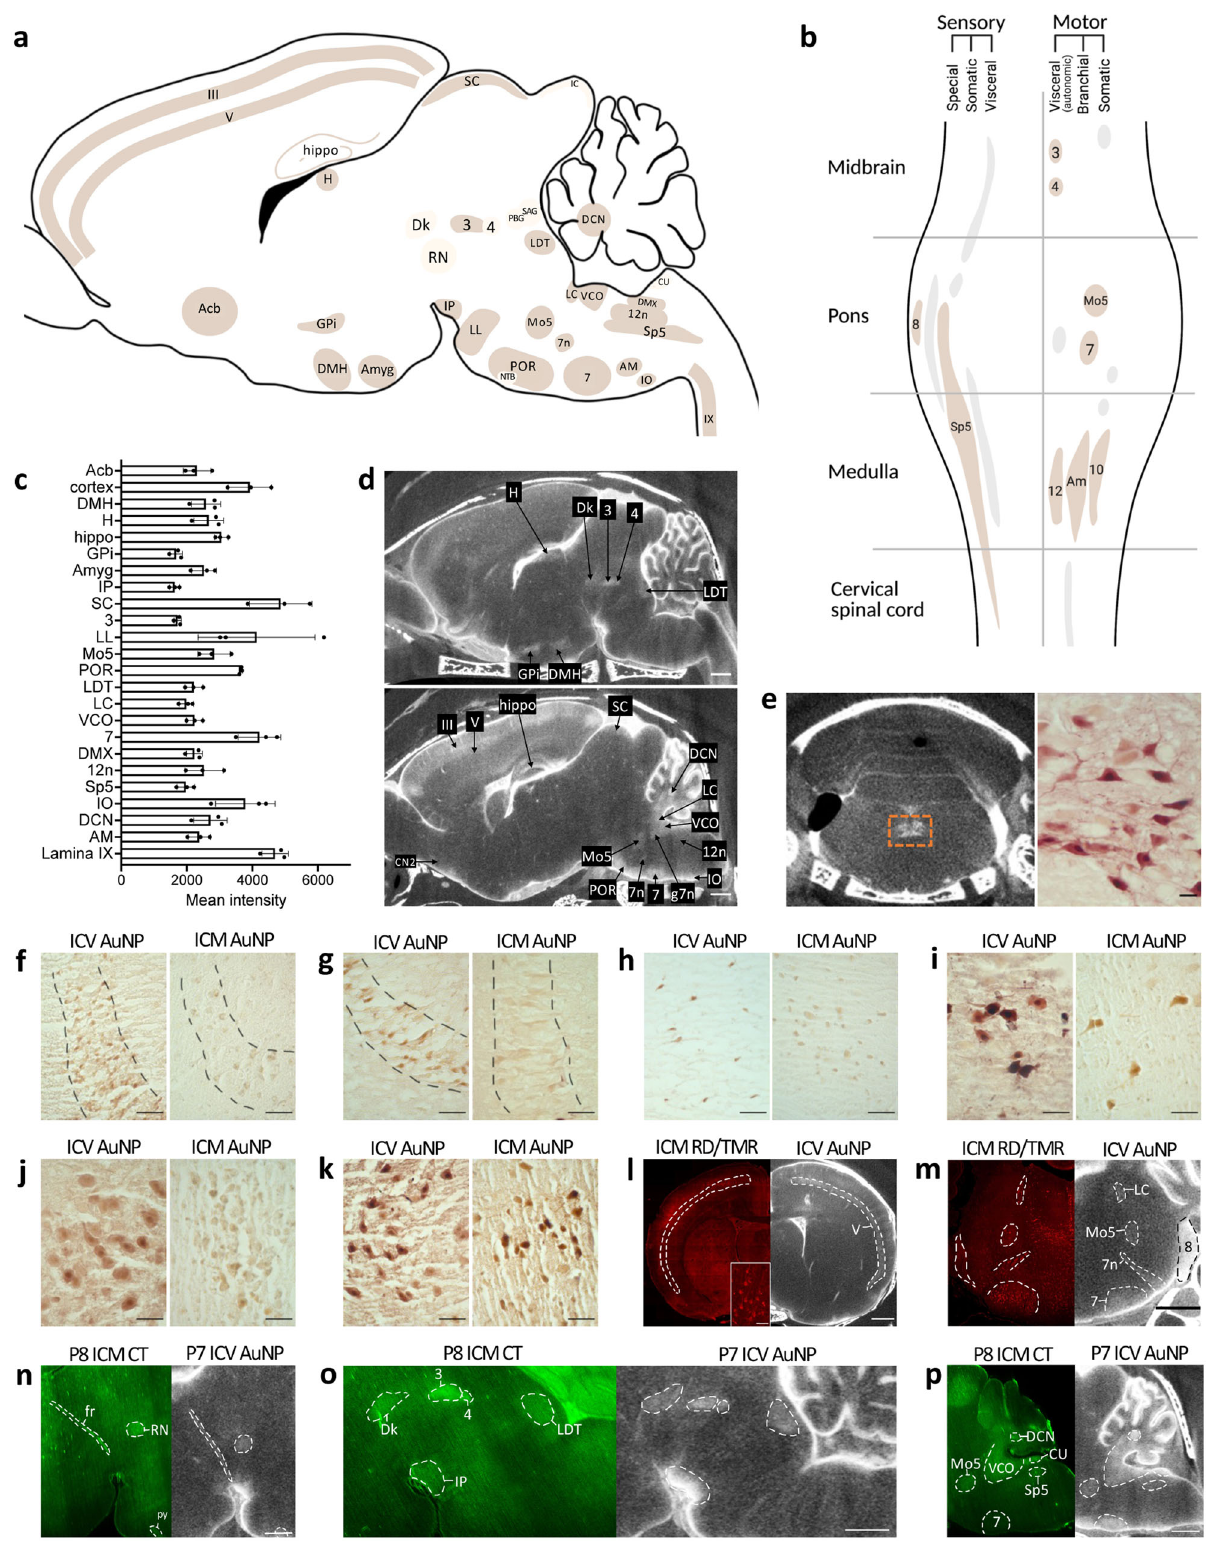
(Supplementary Fig. 8 and Supplementary Tables 2, 3). Co-localization oftissuesectionsforChATandAuNPswasnot possibleasAuNPsblock transmitted light. Therefore, histologic sections from a separate cohort of rats without AuNP injection were stained for ChAT. All but 5 of the 24 functional-anatomic cell groupings had ChAT immuno- fl uorescence in the same anatomic region as the 1.9nm AuNP